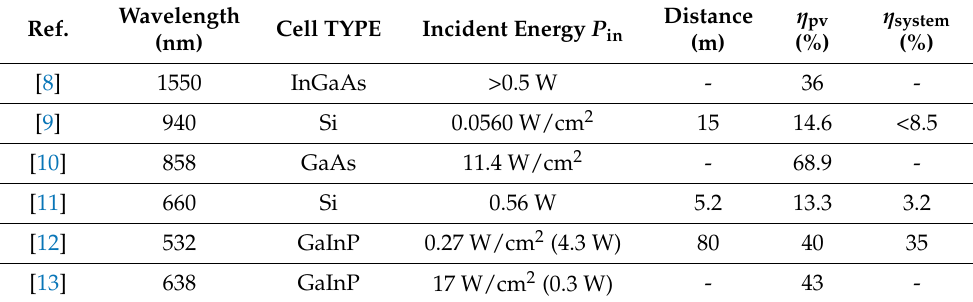
Table 1. Overview of various optical wireless power transmissions.